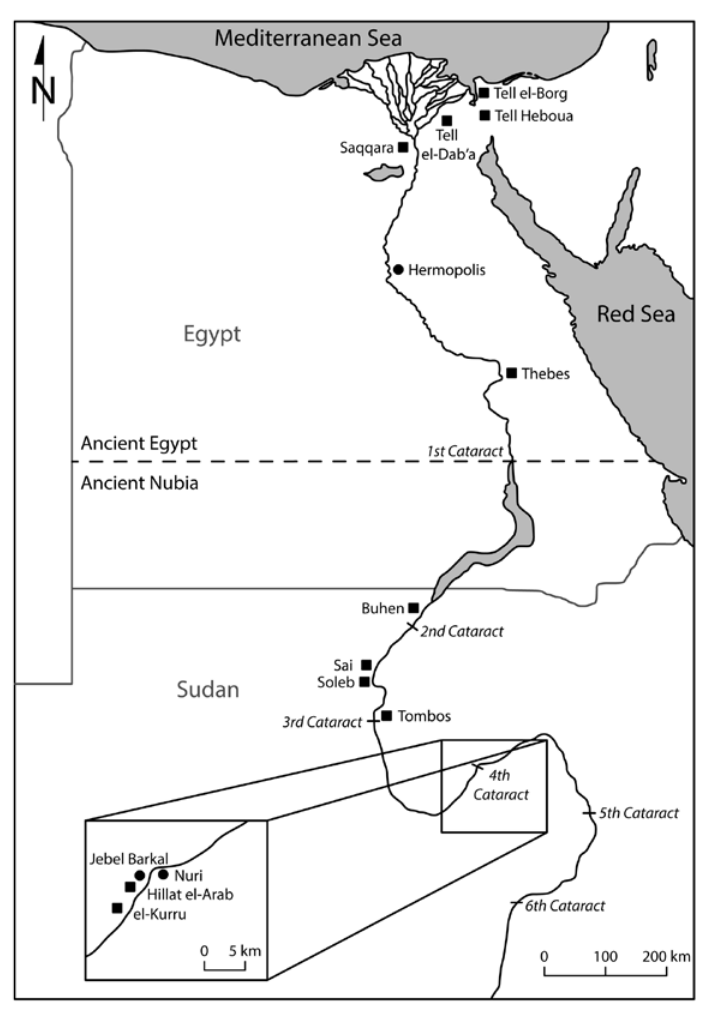
Figure 1 Map of the Egyptian and Middle Nile valley indicating the sites from which horse remains derive. (Image credit: Kay Kossatz, adapted